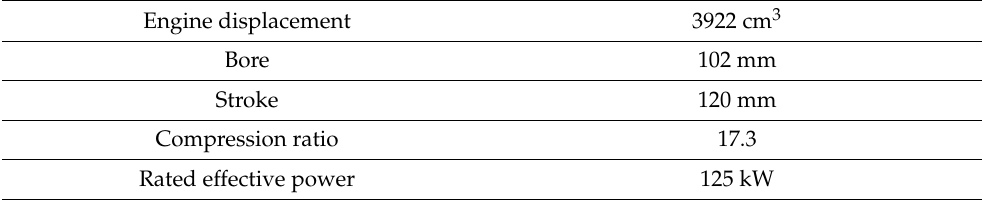
Table 1. Main parameters of the Cummins ISBe 170 30 commercial diesel